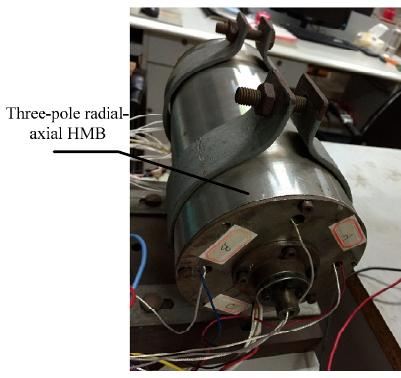
Figure 5. The prototype of three ‐ pole radial ‐ axial hybrid magnetic bearings (HMB).